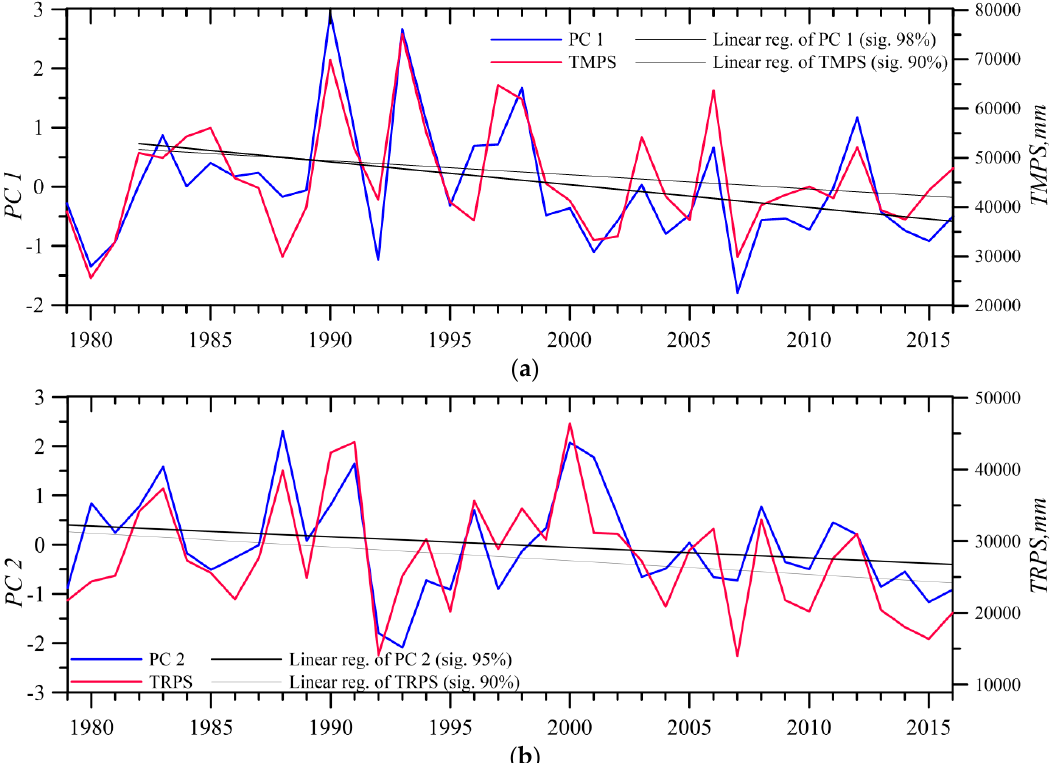
Figure 3. Time coefficient of the first EOF (PC 1) and total precipitation in the Mongolian part of the Selenga River Basin (TMPS) ( a ), time coefficient of the second EOF (PC 2) and total precipitation in the Russian part of the Selenga River Basin (TRPS) ( b ). Thin and thick black lines show the linear trends (sig.: confidence levels at which the linear trend is significant, p -test).